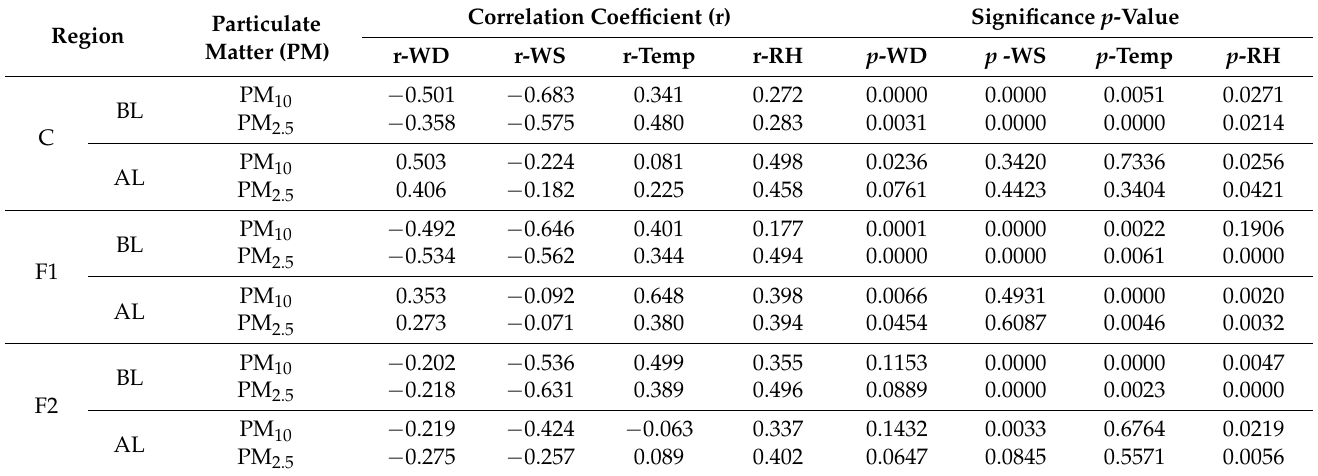
Table 4. Correlation coefficient and p -values of the study sites in Yeouido Saetgang Ecological Park.